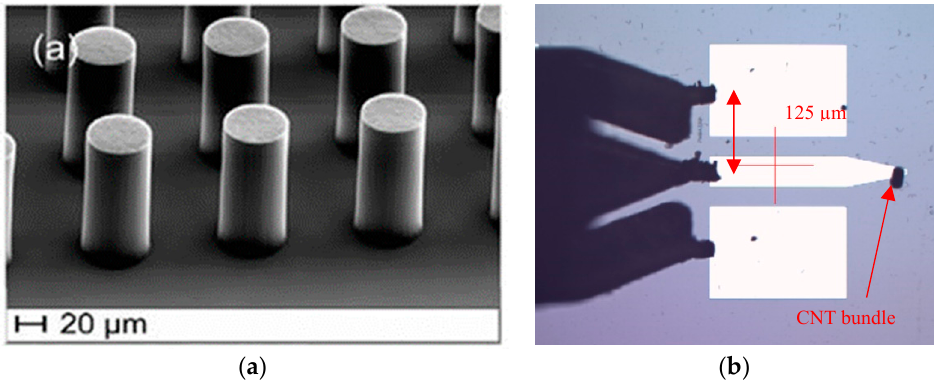
Figure 1. Technological process and Characterization of the vertically aligned multi-wall carbon nanotubes (MWCNTs)-based device. ( a ) SEM (scanning electron microscope) image of CNT bundles grown by Thermal Chemical Vapor Deposition (TCVD) ( b ) Top view of MWCNTs-based device in CPW (coplanar waveguide) technology under a 125-µm-pitch test probe (optical microscope image).